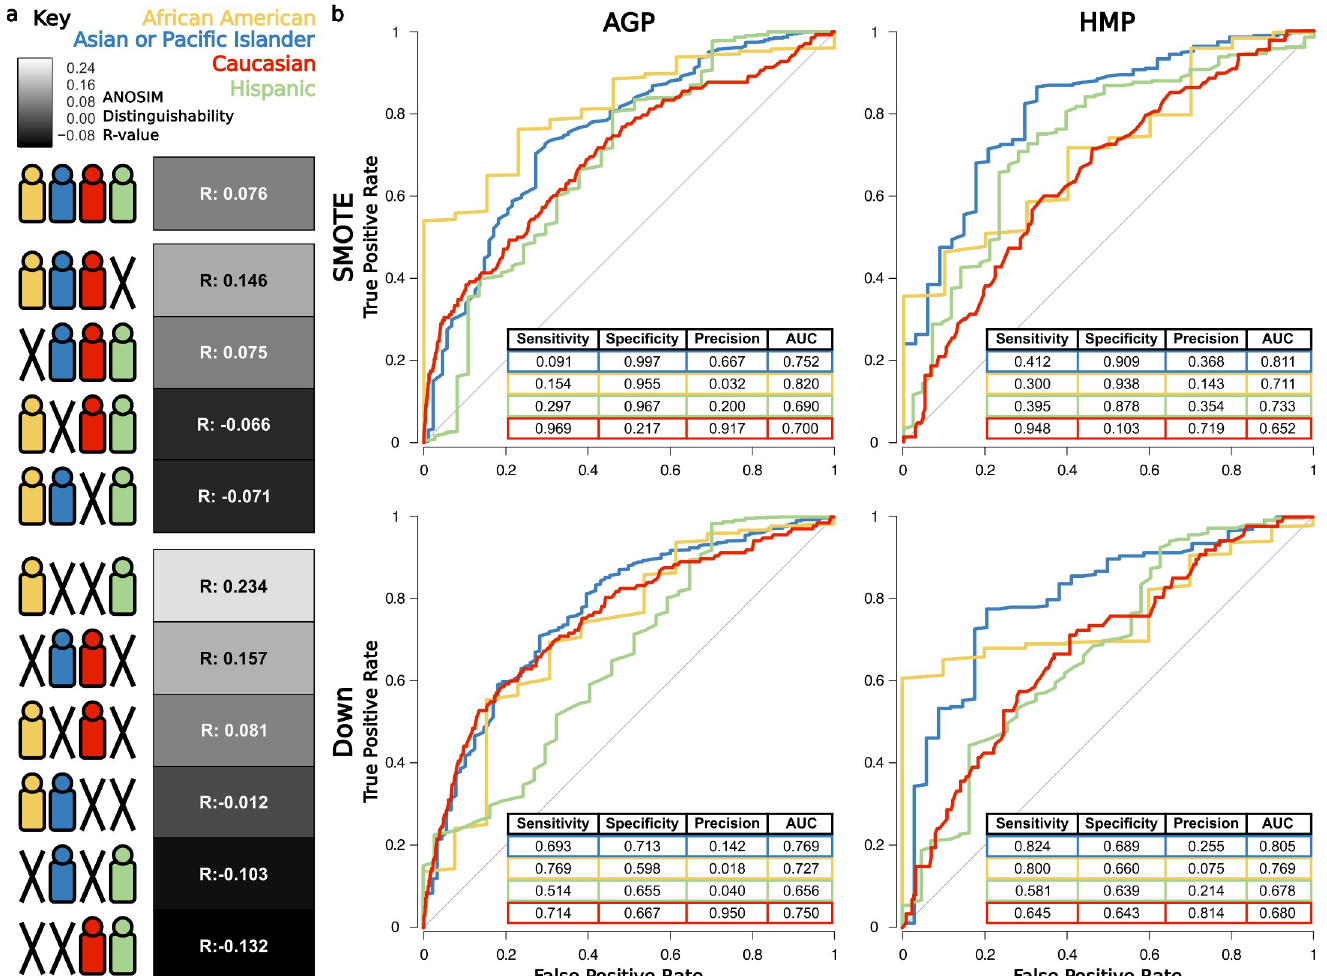
Fig 3. Microbiota distinguishability and classification ability across ethnicities. (A) ANOSIM distinguishability between all combinations of ethnicities. Symbols depict specific ethnicities included in the ANOSIM tests, and boxes denote the R-value as a heatmap, in which white indicates increasing and black indicates decreasing distinguishability relative to the R-value with all ethnicities. (B) Average ROC curves (for 10-fold cross-validation) and prediction performance metrics for one-versus-all RF classifiers for each ethnicity, using SMOTE [33] and down subsampling approaches for training. Data available at https://github.com/awbrooks19/ microbiota_and_ethnicity. ANOSIM, analysis of similarity; RF, random forest; ROC, receiver operating characteristic; SMOTE, synthetic minority oversampling technique.